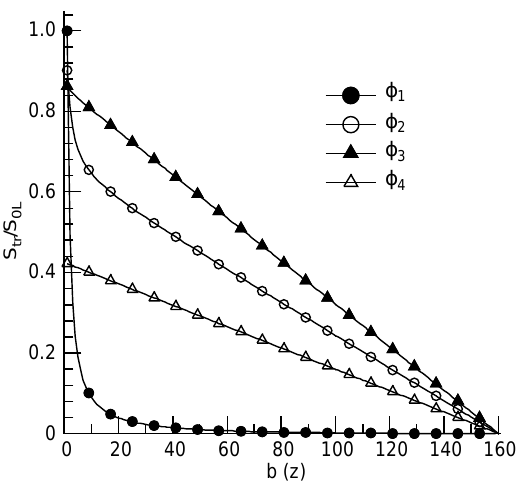
Fig. 4. The dependence of fluxes of trapped electrons along a magnetic flux tube on b z (cid:133) (cid:134) (cid:136) B z (cid:133) (cid:134) = B L , in the case of strong di(cid:128)usion;